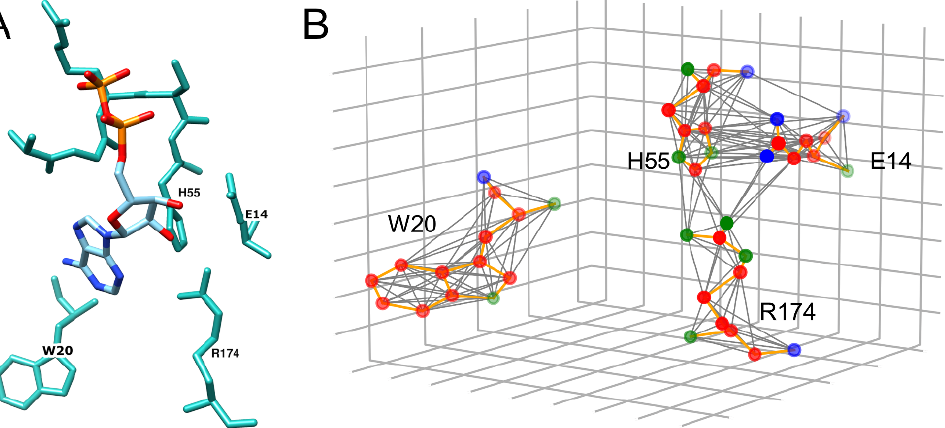
Figure 1. Example of the graph representation of a binding site. ( A ) The structure of a binding pocket for ADP in DnaA regulatory inactivator Had from E . coli (PDB-ID: 5x06). ( B ) The graph representation of four residues, W20, R174, E14, and R53, selected from ( A ).